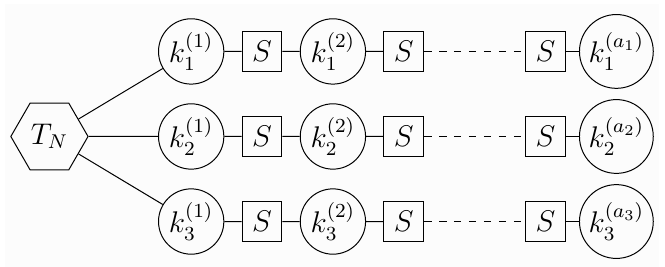
Figure 8 . The 3d theory associated to the Seifert bundle over S 2 with three singular fibers. For the notation, see the main